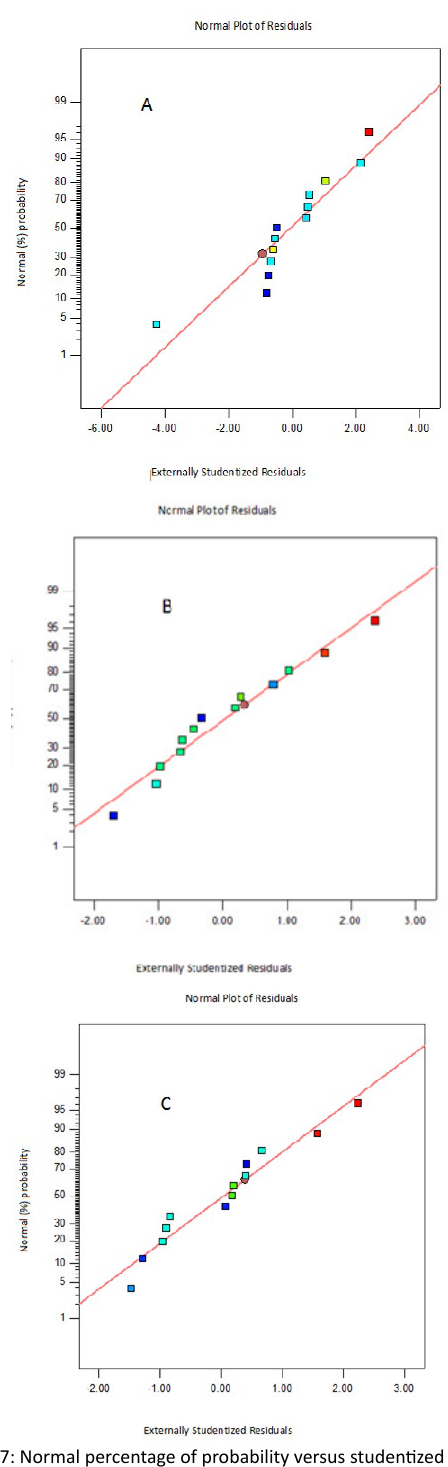
Fig. 7: Normal percentage of probability versus studentized residuals for (a) biochar yield (b) COD removal and (c) colour removal